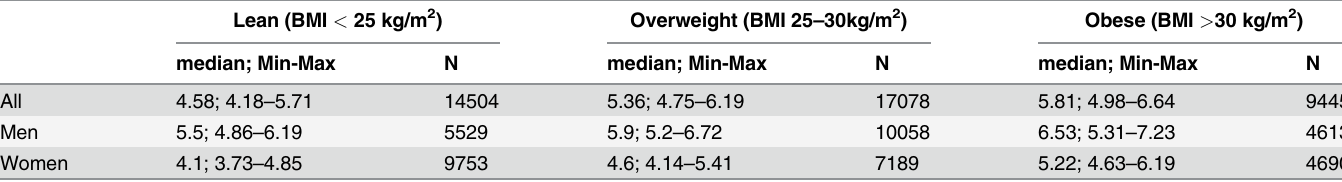
Median, Minimum and Maximum values for the mean serum urate (SU) concentrations (mg/dl) amongst the twenty two studies used in the BMI